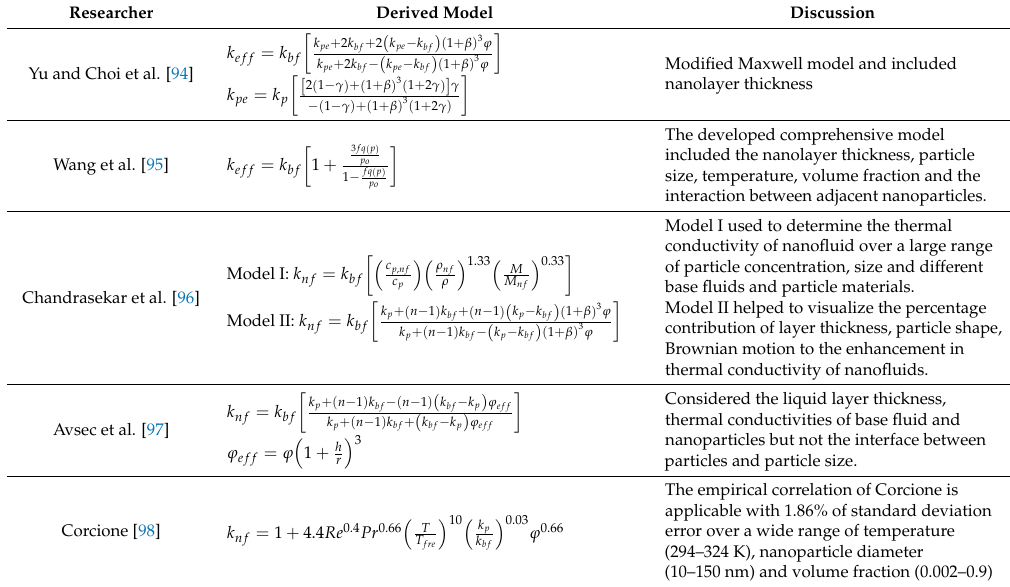
Table 1. Thermal conductivity models.